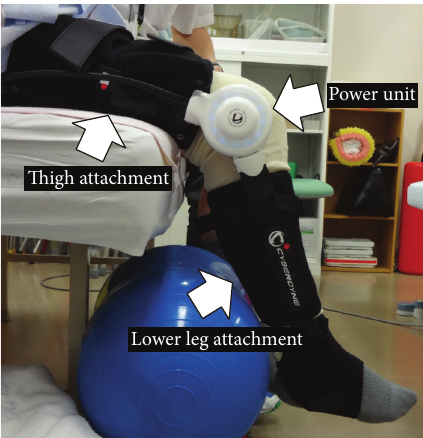
Figure 1: Lateral image of the single-joint hybrid assistive limb on the patient’s right knee joint. Thigh and lower leg attachments are adjusted to the patient’s body and connected by a power unit.